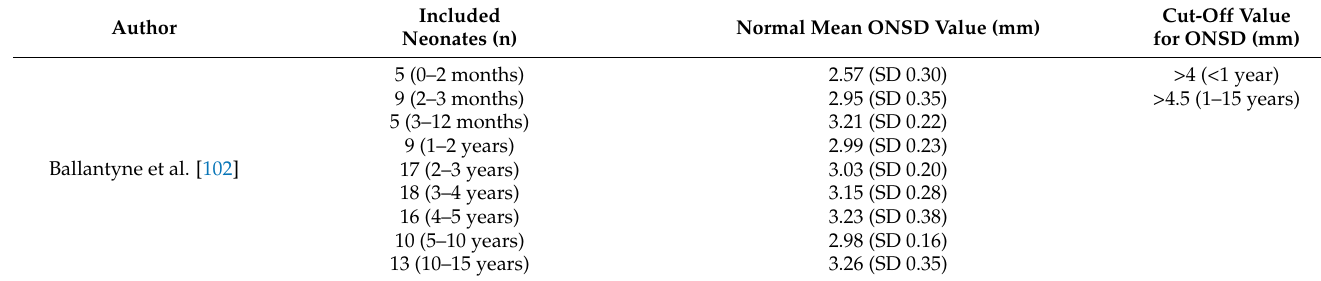
Table 3. ONSD values in the neonatal population: study characteristics (SD, standard